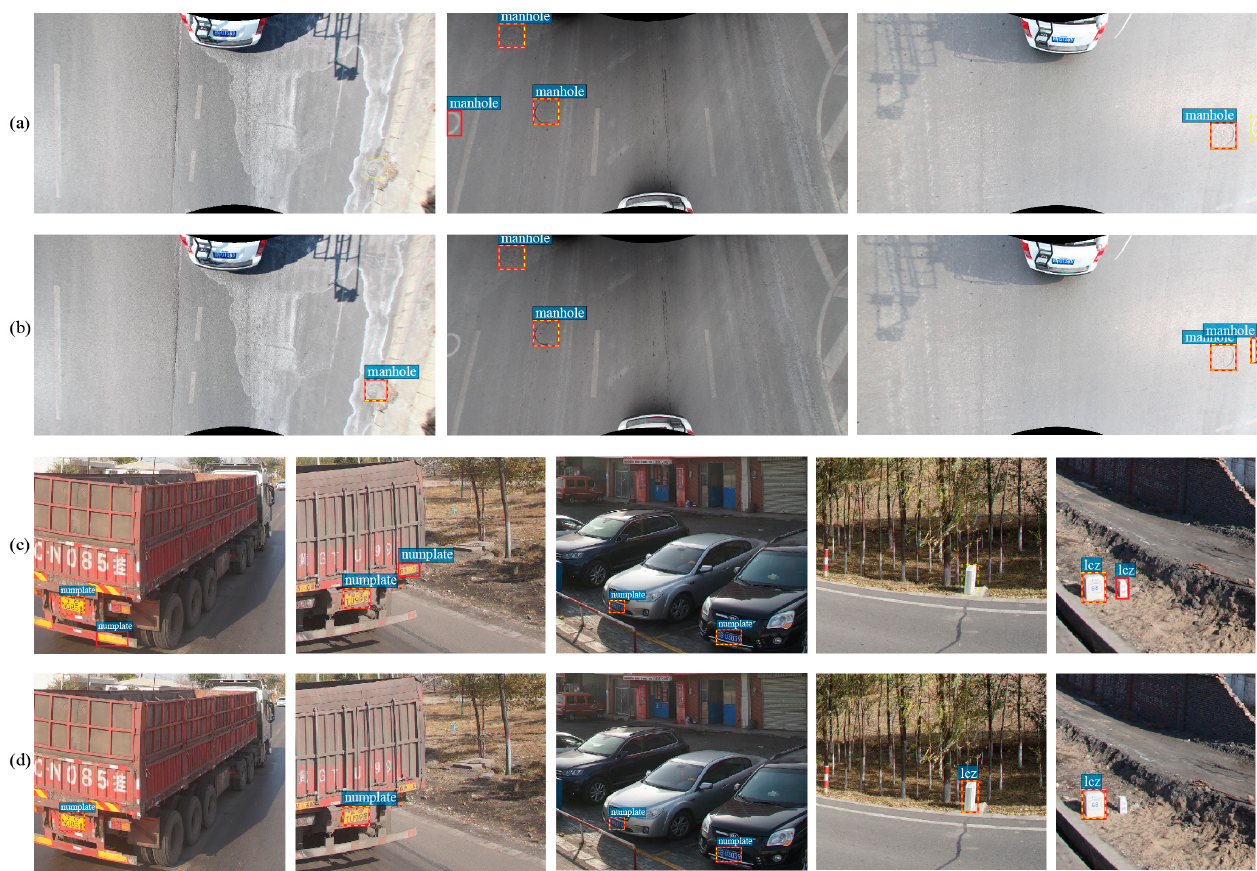
Figure 6. Performance of the baseline Faster R-CNN and our proposed model on the UED dataset. ( a , c ) are performance of the baseline Faster R-CNN. ( b , d ) are performance of our proposed model. Red is the predicted bounding box and yellow is the ground reference bounding box.